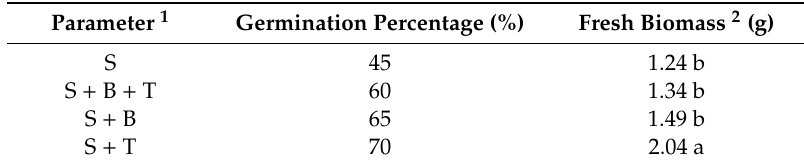
Table 1. Effect of inoculants on germination percentage and seedling biomass 10 days after inoculation (DAI) at in-vitro conditions.